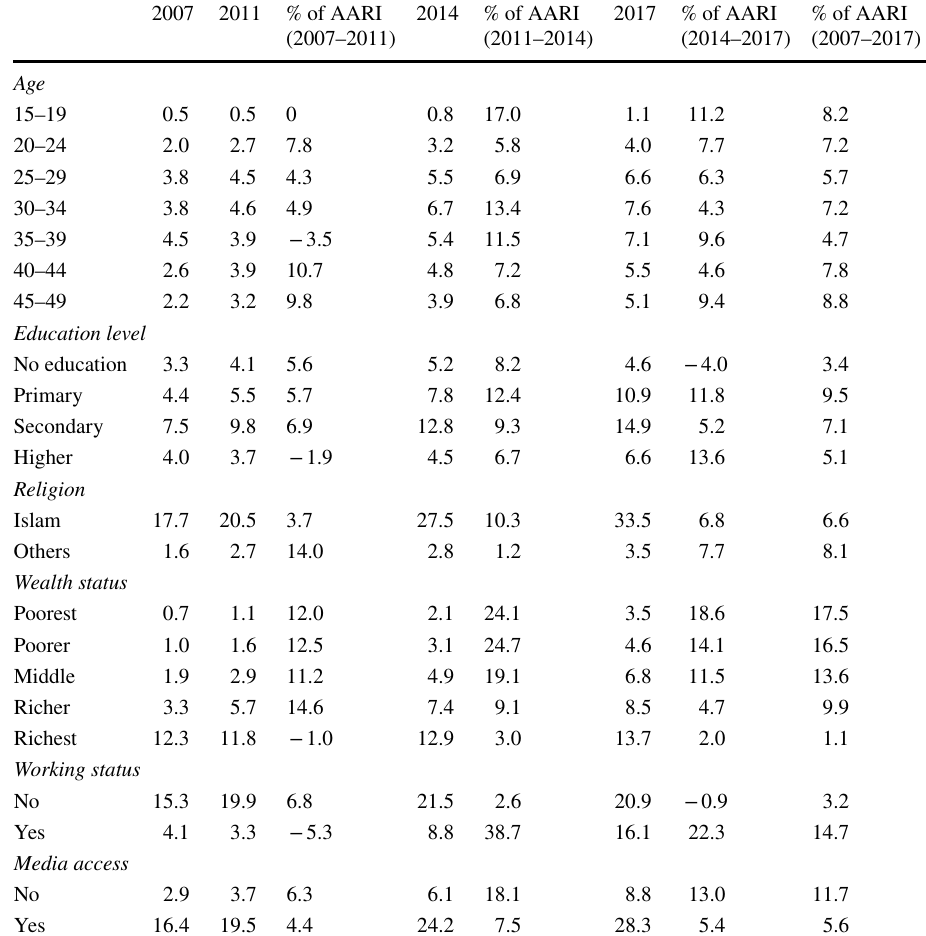
Table 2 Average annual rate of increase (AARI) of being overweight/obese among women in Bangladesh according to BDHS 2007–2017